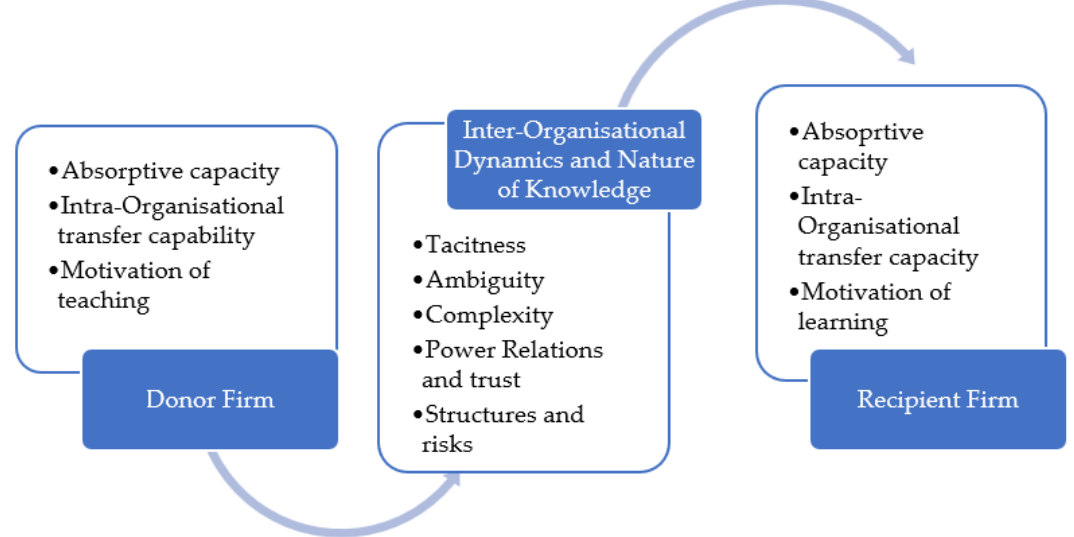
Figure 1. Inter-organisational knowledge transfer and the factors influencing the knowledge transfer (adapted from [20]).